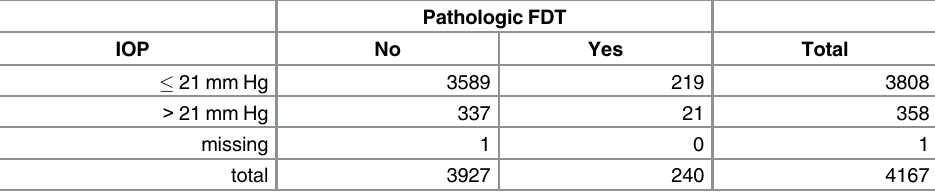
Table 5. Distribution of elevated IOP and pathological FDT, based on both